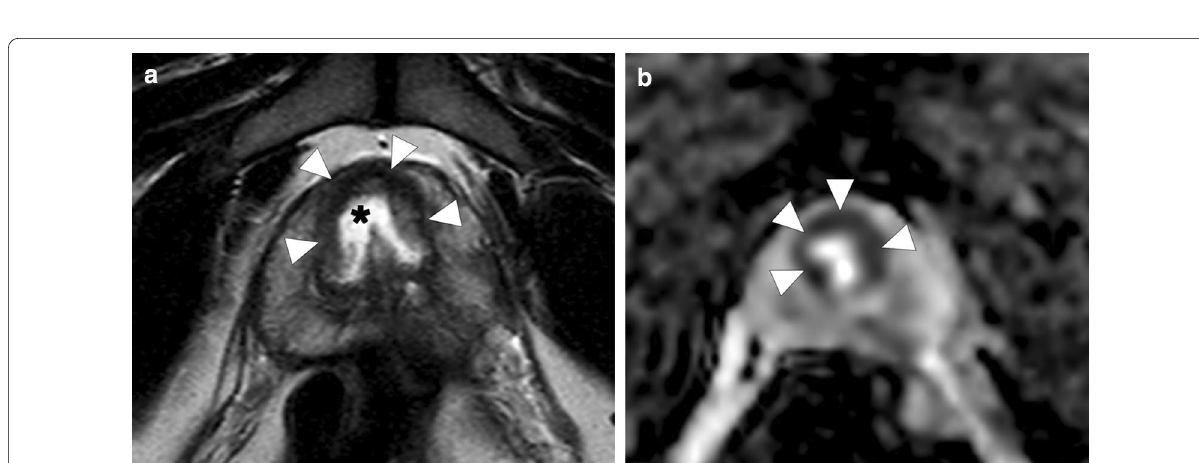
Fig. 2 Prostatic involvement by granulomatosis with polyangiitis. A 31-year-old man with no known systemic disease presented with severe dysuria and hematuria. Serum PSA levels were also increased. Axial T2-weighted MR image a of the prostate demonstrates heterogeneous ill-defined, mostly hypointense lesion (arrowheads) in the prostate apex. A small cystic cavity appears in the central part of the lesion (asterisk). Axial ADC map (b 800 s/mm 2 ; 1.5 T) b shows diffusion restriction in the peripheral part of the lesion, suggestive of increased cellularity (arrowheads). = Fusion guided transrectal biopsy revealed granulomatous prostatitis consistent with granulomatosis with